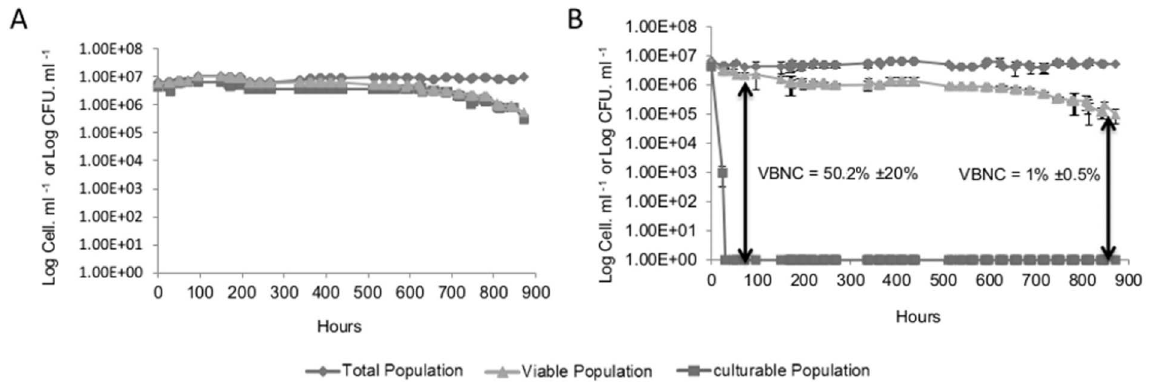
Figure 1. Changes in the total cell population ( ¤ ) culturable population ( & ), and viable population ( m ) of a culture of S.cerevisiae S288C on incubation at 28 u C. Panel A shows the growth control condition in synthetic wine. Panel B shows the induction of VBNC state in S. cerevisiae S288C in synthetic wine with the addition of 4.5 mg/L molecular SO 2 at time 0. Value 1 corresponds to an undetectable number (less to 10 CFU/mL).The values presented are the average of three replicates of three separate experiments.